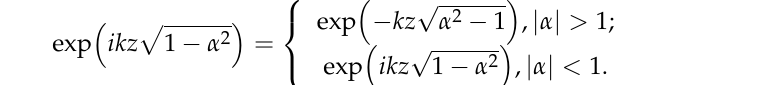
Figure 2. Features of the superoscillating field: comparative distributions for the functions of Equation (1)—bold line, Equation (2)—dashed line, and of Equation (3)—thin line.